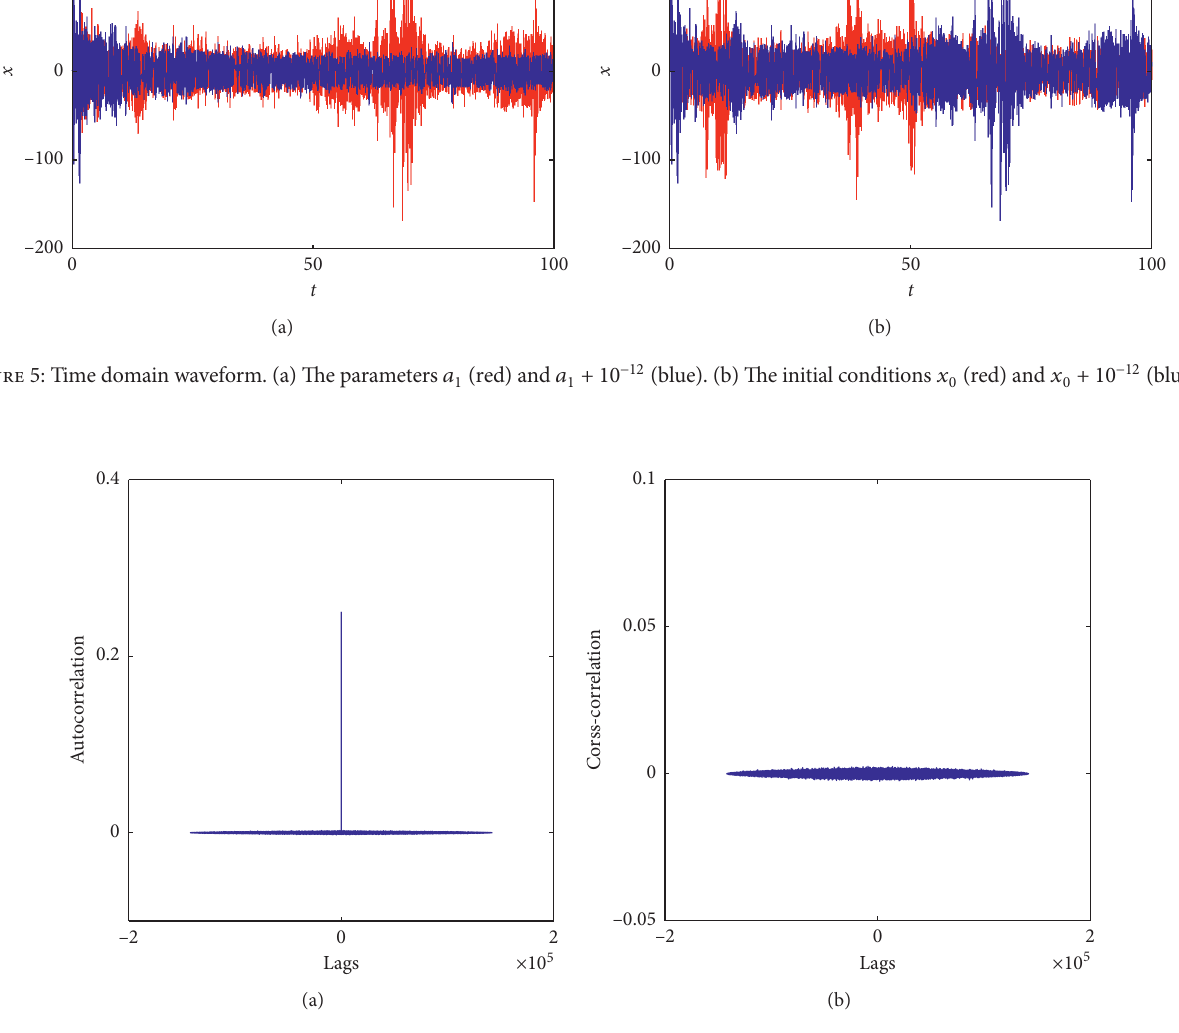
Figure 5: Time domain waveform. (a) The parameters a